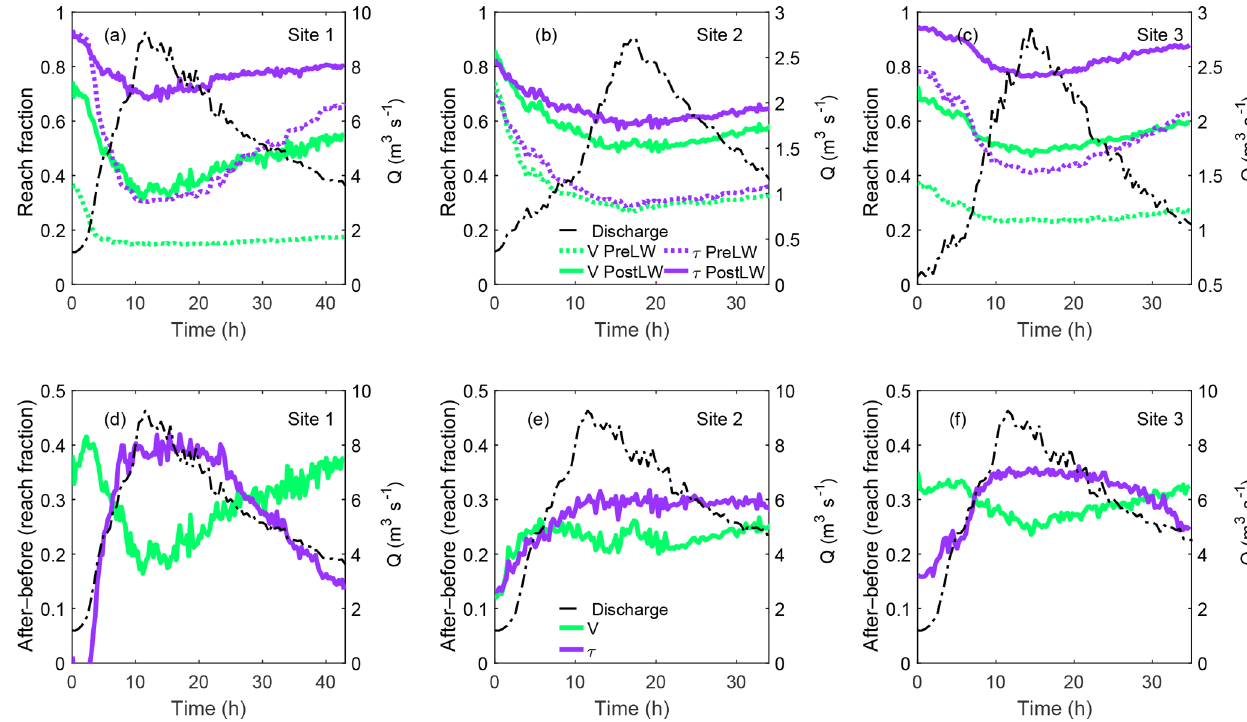
Figure 7. (a–c) Fraction of the flow domain with v<v crit or τ<τ c during simulated 40–35h bankfull flow events in the three study sites pre- and post-LW; (d–f) differences between after and before LW additions in the fraction of the reach area with v<v crit or τ<τ c